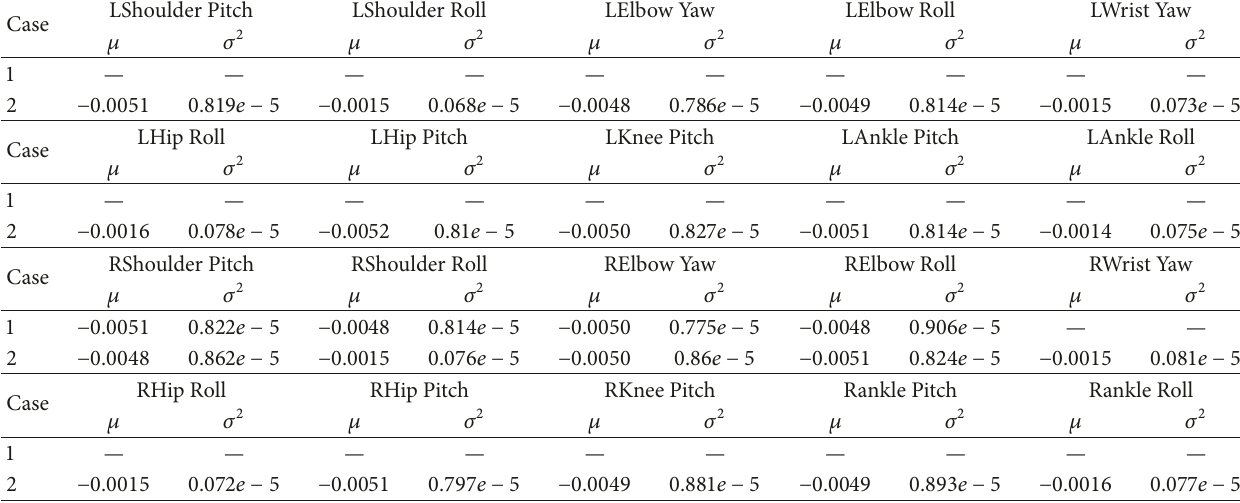
Table 3: Statistics for offline